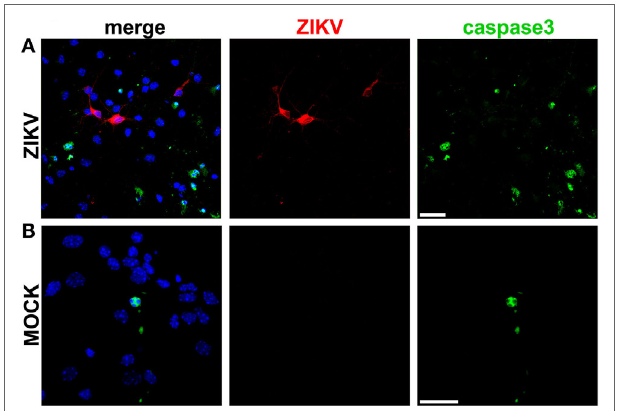
FigUre 1 | Zika virus (ZIKV) induces apoptosis in a non-cell autonomous manner. Shown are representative laser scanning confocal micrographs from primary cultured corticostriatal neurons infected with ZIKV (a) or MOCK- infected (B) for 48 h. Immunofluorescence labeling was performed using anti-ZIKV (red) and anti-active caspase 3 (green) antibodies. Cells nuclei are labeled with DAPI (blue). Panels on the left show merged image of all three fluorescent markers. Size bar corresponds to 20 µm in all